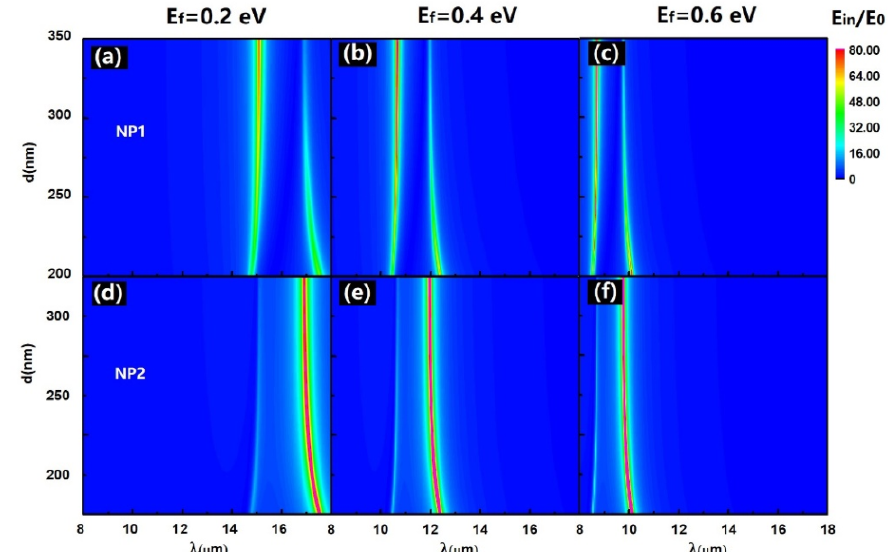
Figure 8. Internal field enhancement as the functions of center-to-center distance d and incident wavelength λ in NP1 (Upper panel) and NP2 (lower panel) with di ff erent Fermi energy levels: ( a , d ) E F = 0.2 eV, ( b , e ) E F = 0.4 eV, and ( c , f ) E F = 0.6 eV, respectively. The radius of NP1 is 80 nm and other parameters are the same as used in Figure 2.